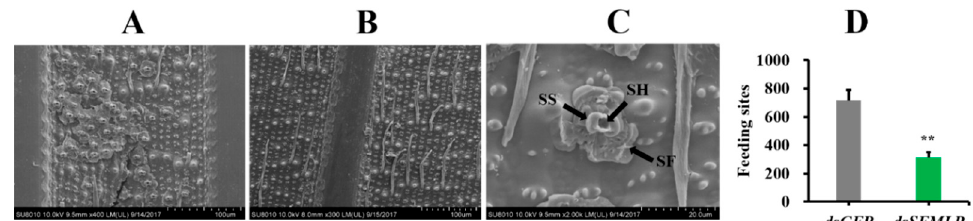
Figure 7. Effects of SFMLP knockdown on the probing trace of WBPH. ( A ) WBPH injected with dsGFP ; ( B ) WBPH injected with dsSFMLP ; ( C ) enlargement of the probing trace. SS, salivary sheath; SH, stylet hole; SF, salivary flange; ( D ) the flange number of WBPH injected with dsSFMLP . After feeding on rice for 24 h, the salivary sheaths were collected and observed under SEM. ** indicates statistically significant differences ( t- test: p < 0.01). Bars, ±